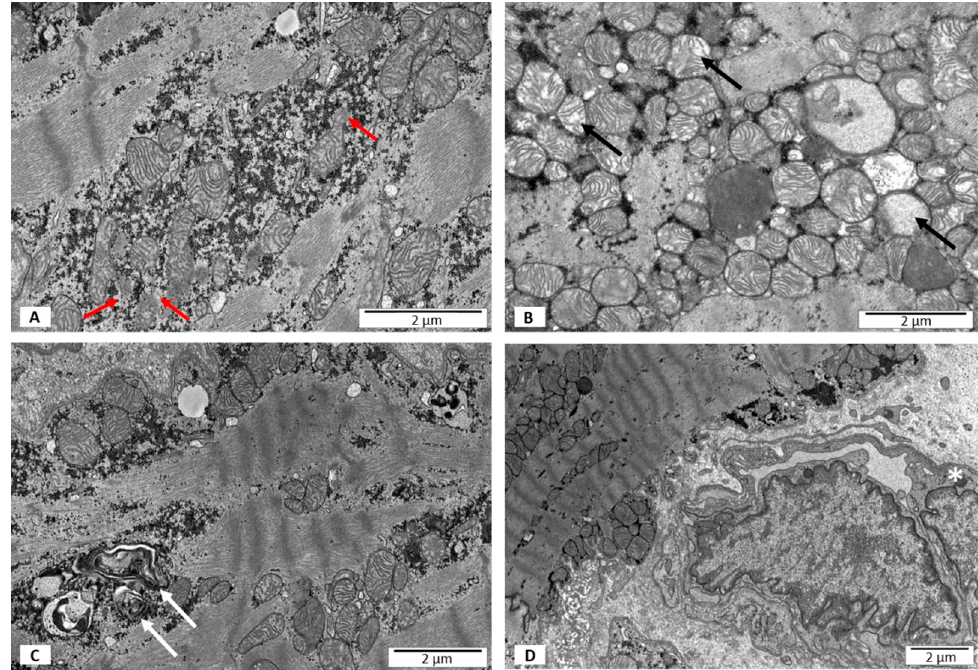
Figure 2. Electron microscopy images. Ultrastructural features of heart biopsies from patients with EF < 50% and no virus detected. ( A ) A disrupted outer mitochondrial membrane marked with red arrows; ( B ) partial loss of mitochondrial cristae and swollen mitochondria marked with black arrows; ( C ) lysosomes and autophagous figures containing remnants of mitochondrial cristae marked with white arrows; ( D ) no features of necrosis; hypertrophic endothelium marked with an asterisk.